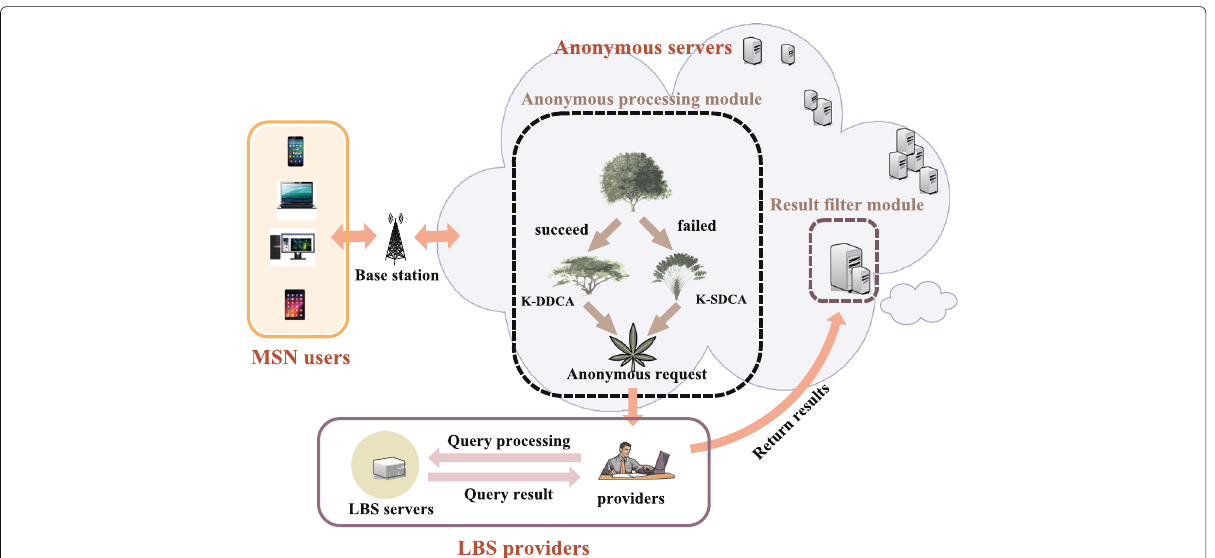
Fig. 4 Architecture of the proposed system model. It consists of the following three components: (1) MSN user, (2) anonymous servers, and (3) LBS providers. The system model is inspired by the classical central server architecture, and it has more superiorities on anonymous